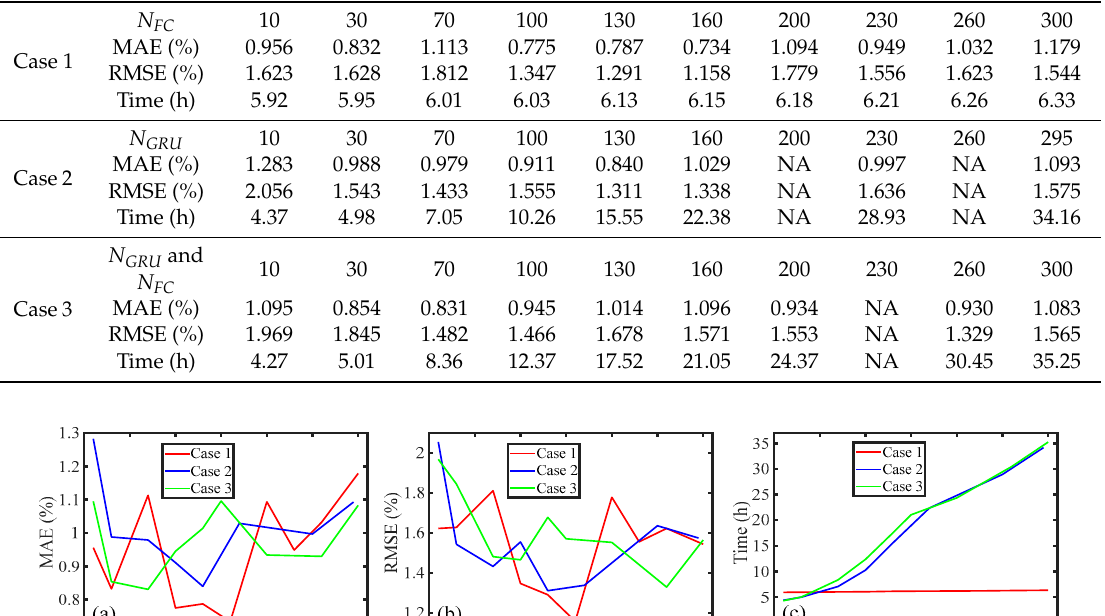
Table 4. Model evaluation indexes under three conditions at 25 ◦ C.